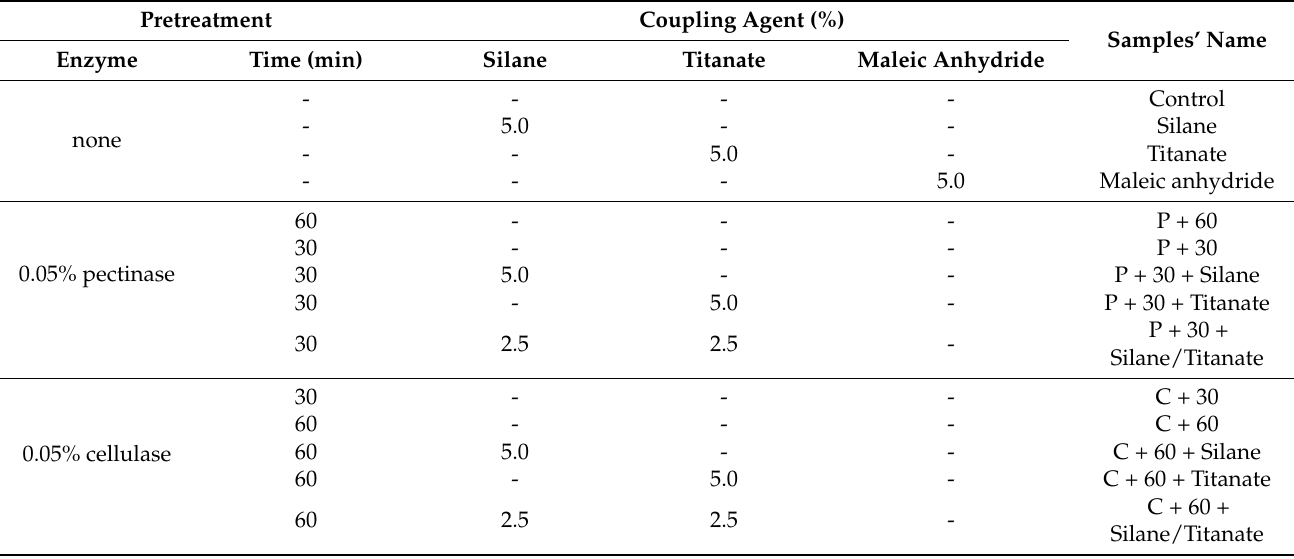
Table 1. Treatments applied to a 70/30 mixture of wood/hemp hurd fibers prior to panel manufacturing and ratios of the resulting fibers and coupling agents used to produce